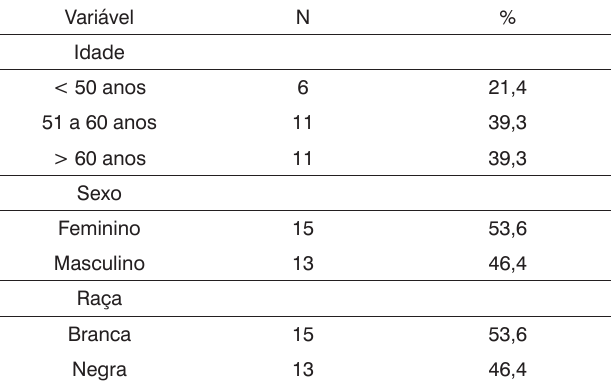
Tabela 1. Dados demográficos da amostra.